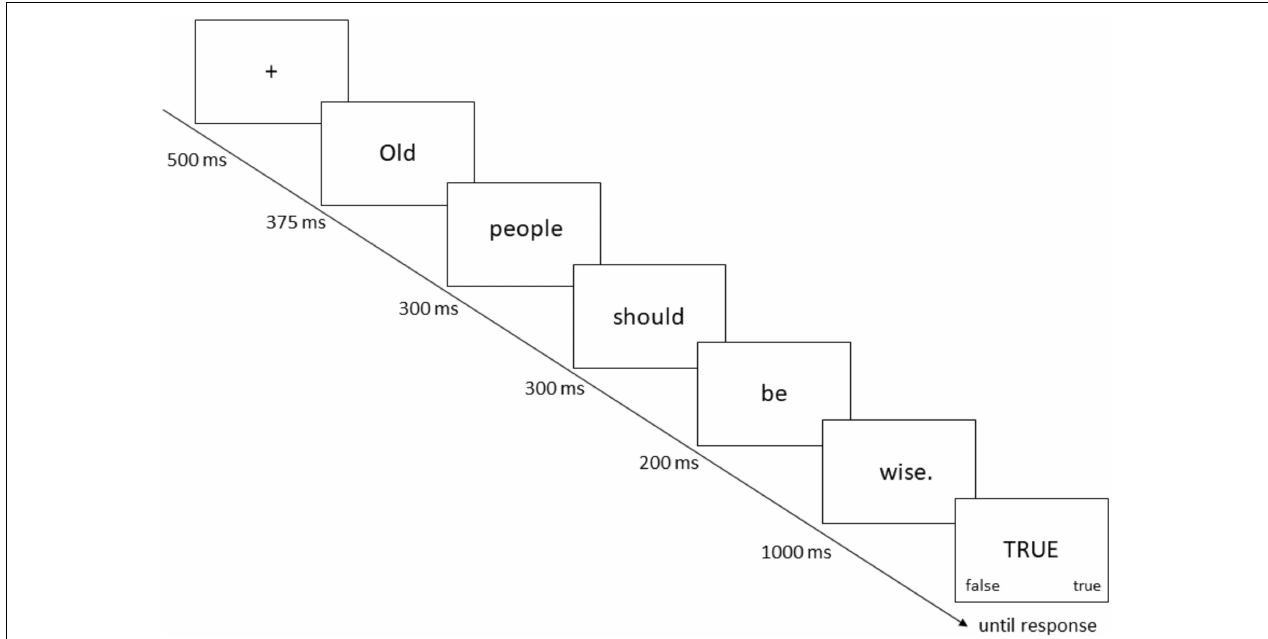
FIGURE 1 | Presentation of a Trial (old sentence, wisdom, “true” prompt) in the PEP Task. Fast responses for “TRUE” probes and slow responses for “FALSE” probes indicate implicit endorsement of the sentence presented before the respective prompt (see Müller and Rothermund,